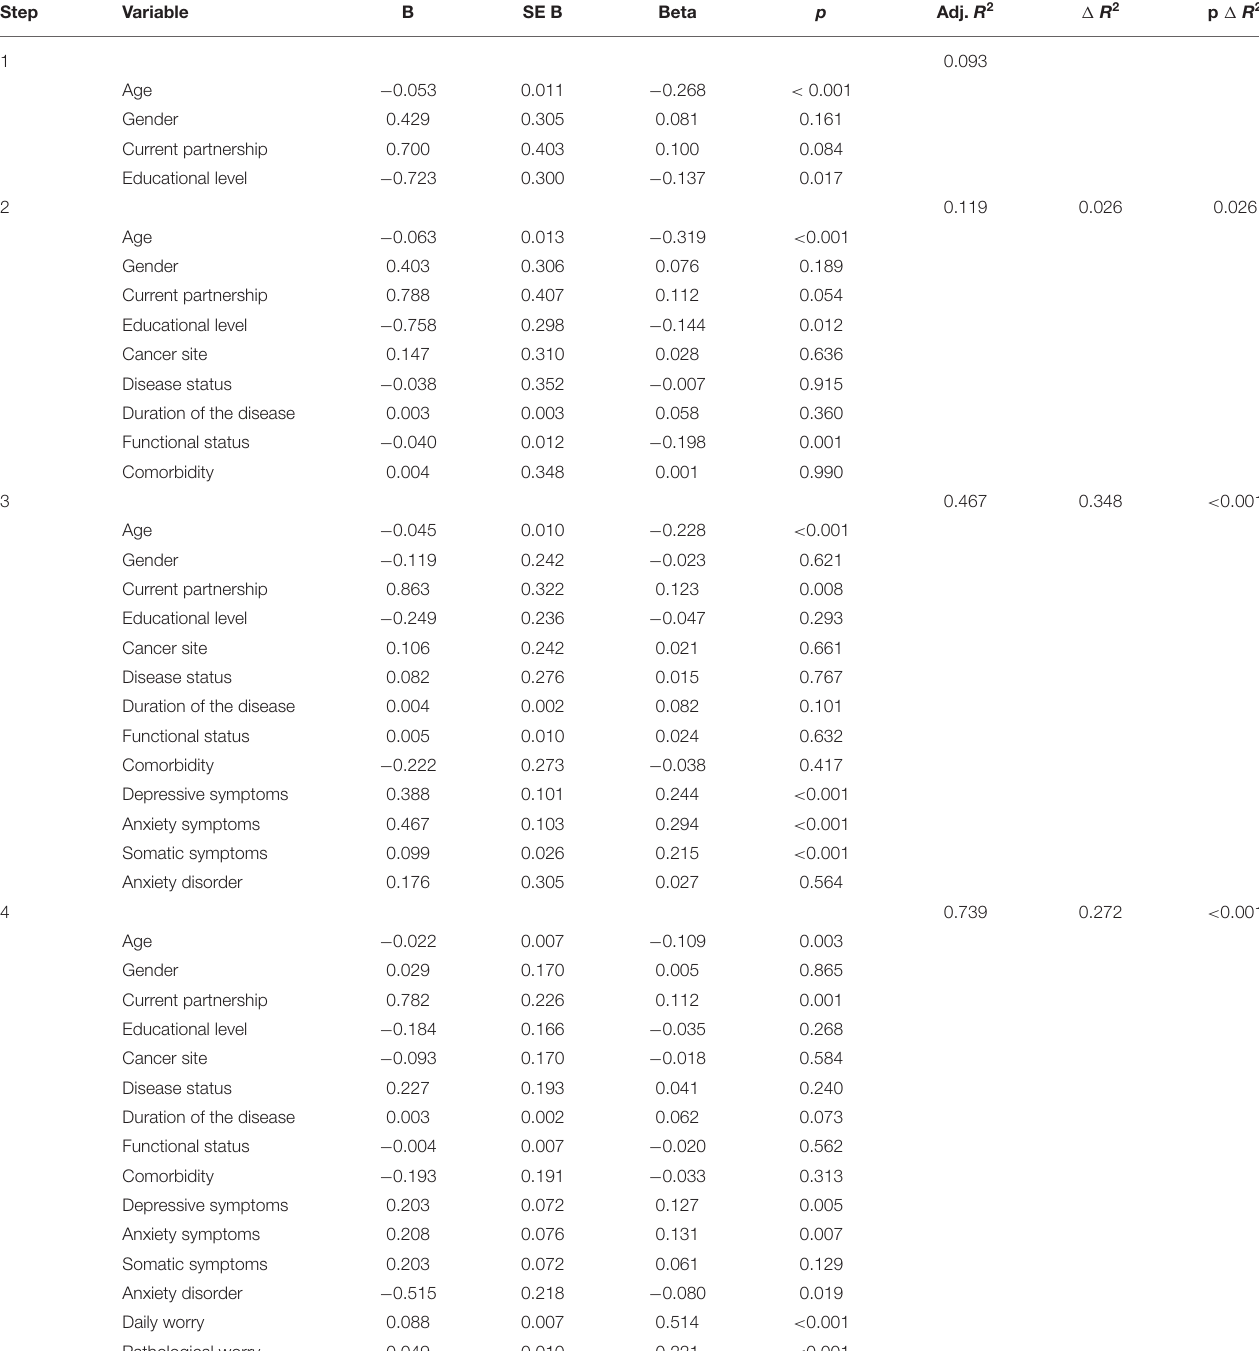
TABLE 3 | Results of the hierarchical multiple regression analysis predicting fear of progression (FoP-Q) ( n =